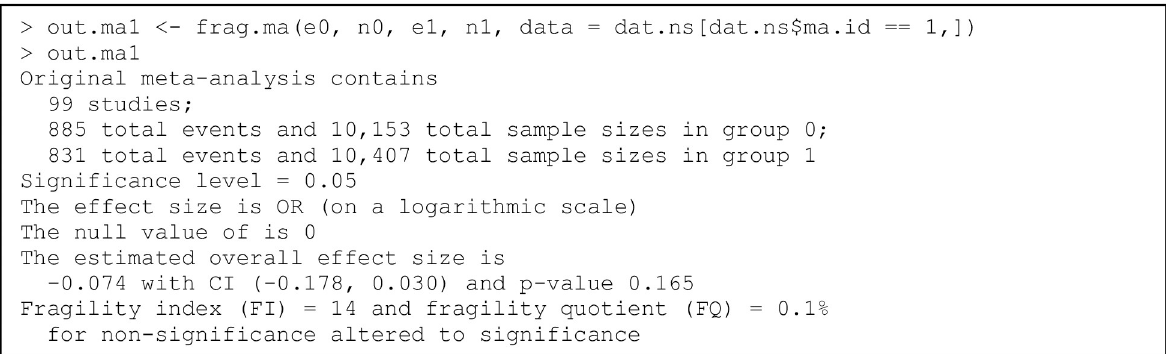
Fig 3. Output from the function frag.ma()